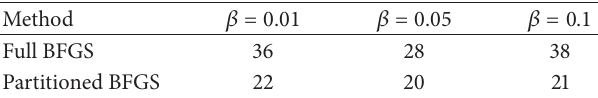
Table 1: Effect of the initialisation of the Hessian approximation on the number of NLP iterations until convergence, test case